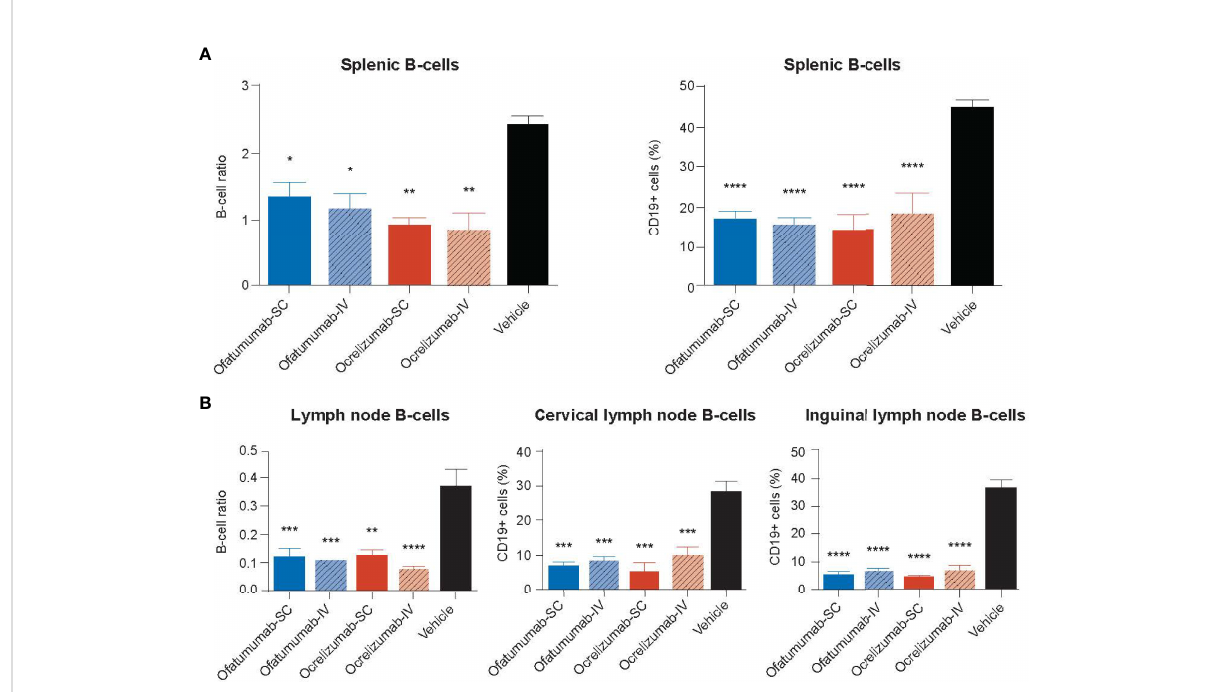
FIGURE 6 (A) The number of CD19+ cells in the spleen and (B) cervical and inguinal lymph nodes following treatment with SC or IV ocrelizumab or ofatumumab. IHC and FACS analysis revealed all treatments signi fi cantly depleted the number of CD19+ cells in the spleen and cervical and inguinal lymph nodes relative to vehicle after 18 days. * p < 0.05, ** p < 0.01, *** p < 0.001, **** p < 0.0001. Data represents mean ± SEM. Vehicle values represent the percentage of the total number of CD19+ cells in the